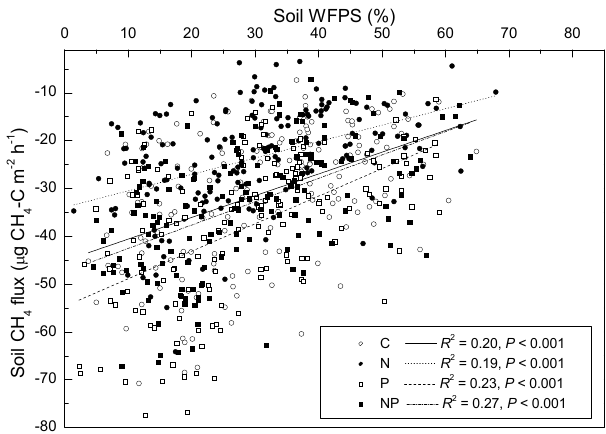
Figure 5. Correlations between CH 4 flux and soil WFPS under different fertilization treatments. Under similar soil WFPS conditions, CH 4 uptake was higher in P-addition plots and lower in N-addition plots.